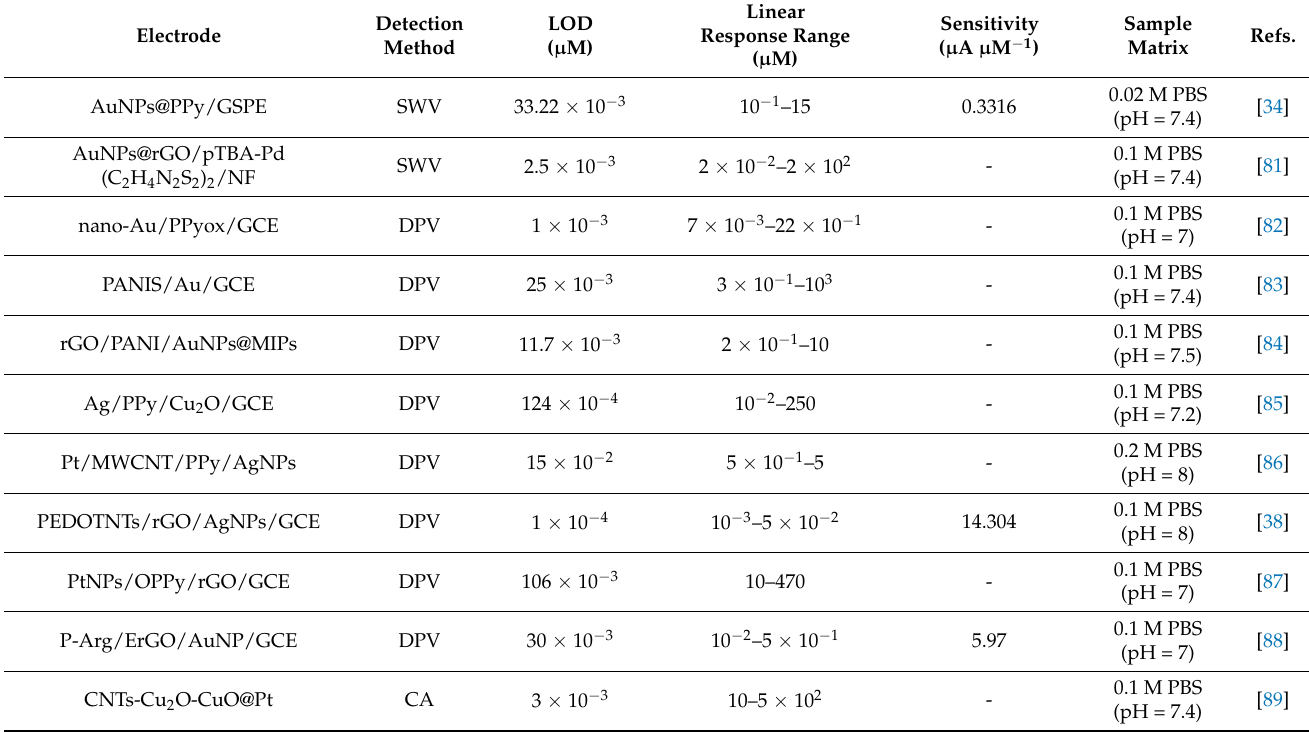
Table 2. Electrochemical sensors for SER detection from recent